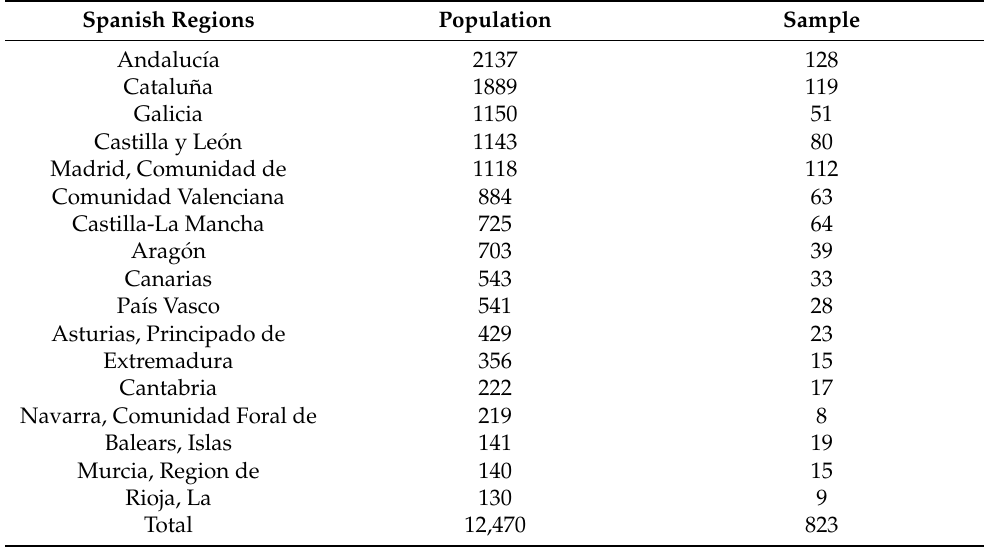
Table 1. Population and